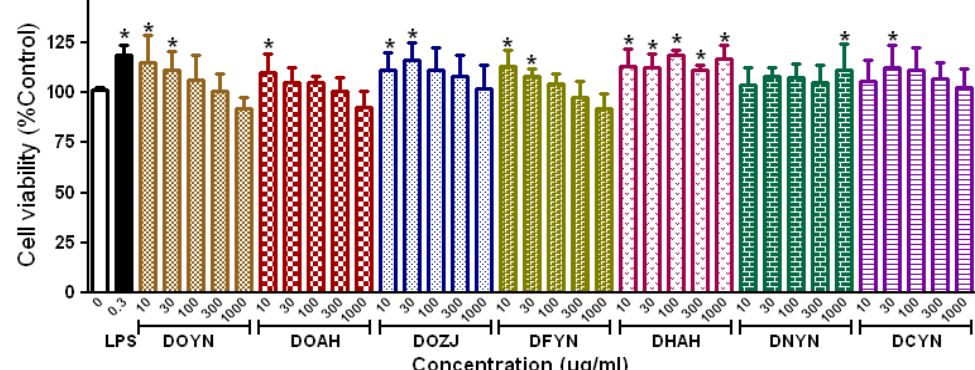
Figure 4. Effects of crude polysaccharides from Dendrobium on RAW 264.7 macrophages proliferation.